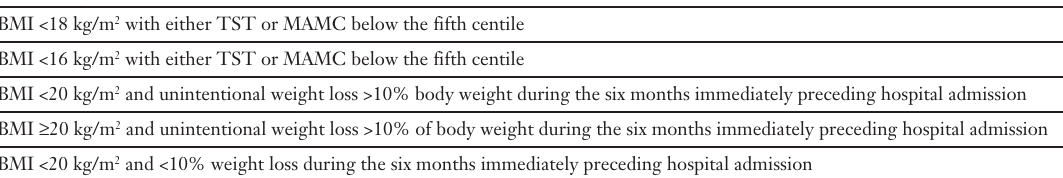
Undernutrition defined according to the criteria of Edington